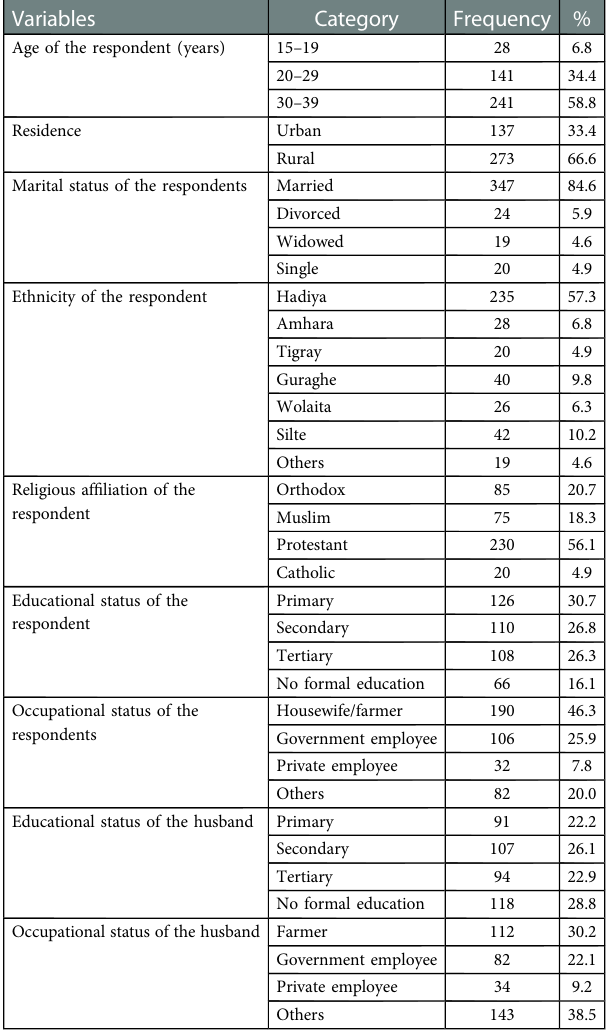
TABLE 1 Sociodemographic characteristics of pregnant women in Hosanna Zuria Kebeles, Hadiya Zone, southern Ethiopia, 2021 ( N =410). Variables